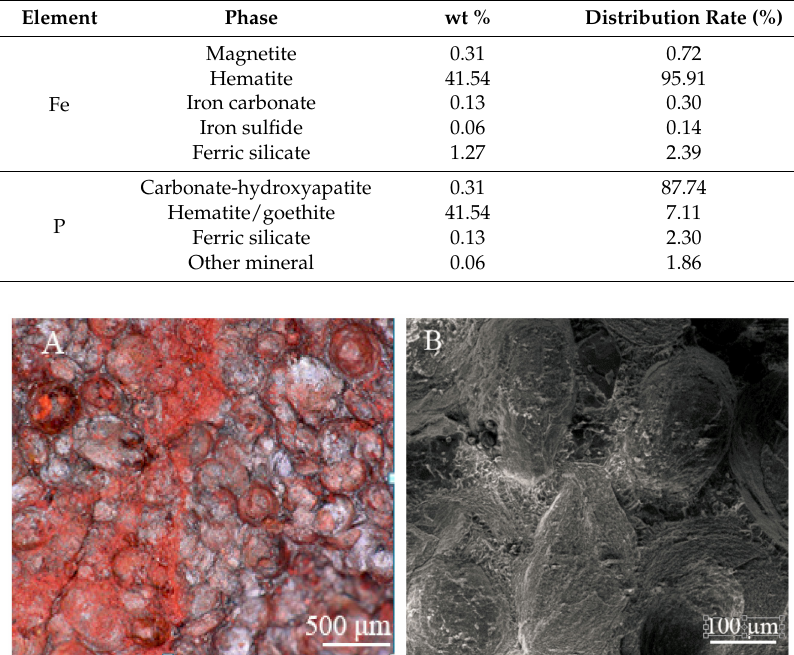
Table 2. Iron and phosphorus content of oolitic hematite.